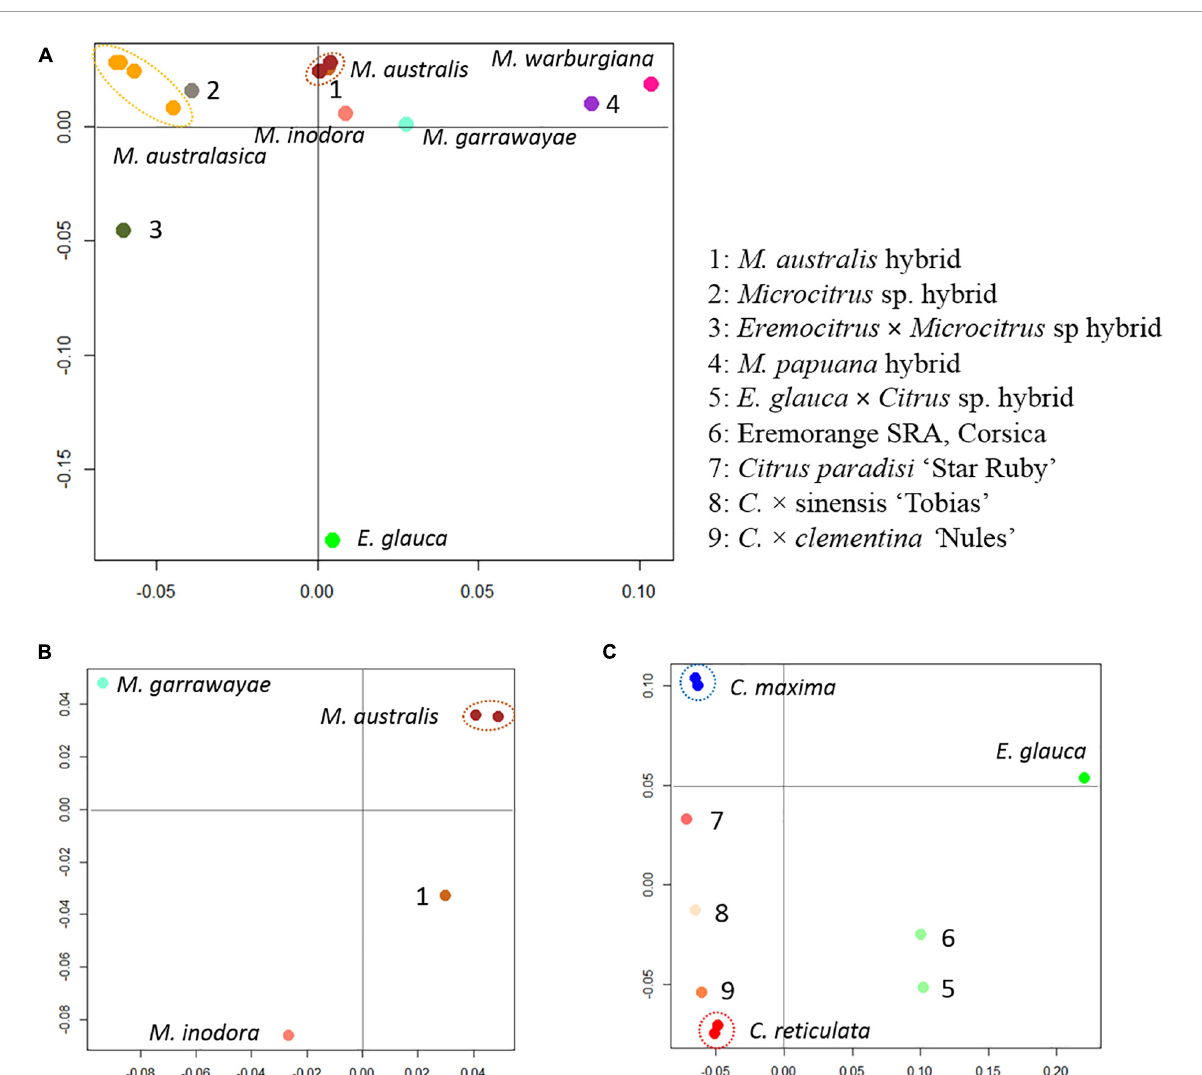
FIGURE5 Factorial analysis from the genotyping of 49,187 diallelic SNPs. (A) Organization of the genetic diversity of the Oceanian germplasm. (B) Focus on the relationship of M. australis hybrid accession with M. australis , M. garrawayae, and M. inodora . (C) Focus on the relationship of the two supposed eremoranges with the C. reticulata / C. maxima gene pools.